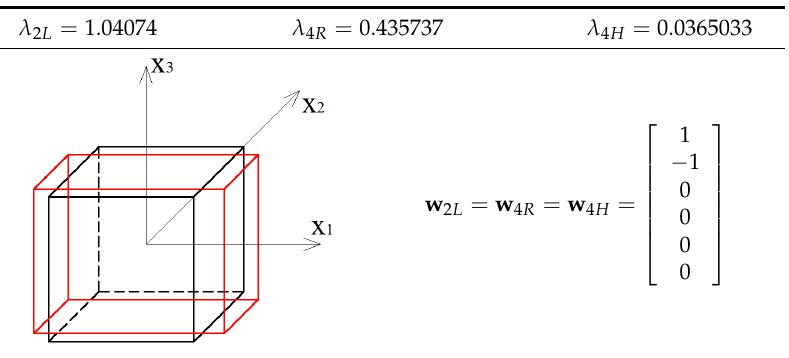
Table 4. High shear modes of deformation.